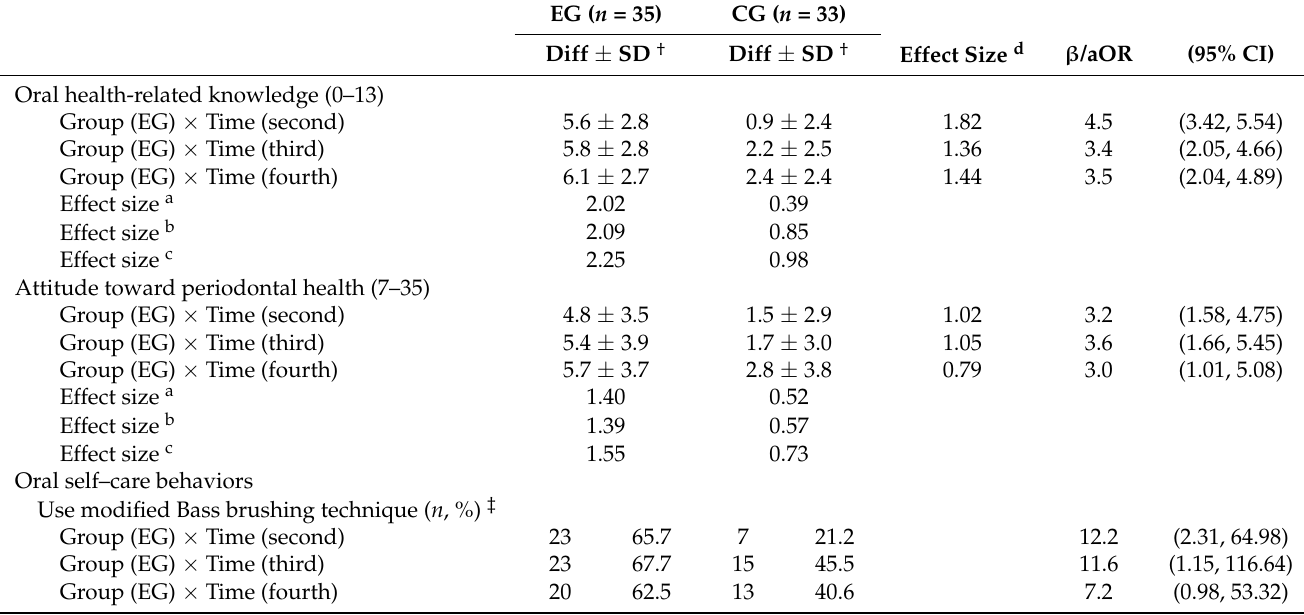
Table 2. Effect of changes in oral health-related knowledge, attitude toward periodontal health, and oral self-care behaviors at different stages (at baseline and at 1-month, 3-month and 6-month follow-up) by group among patients with